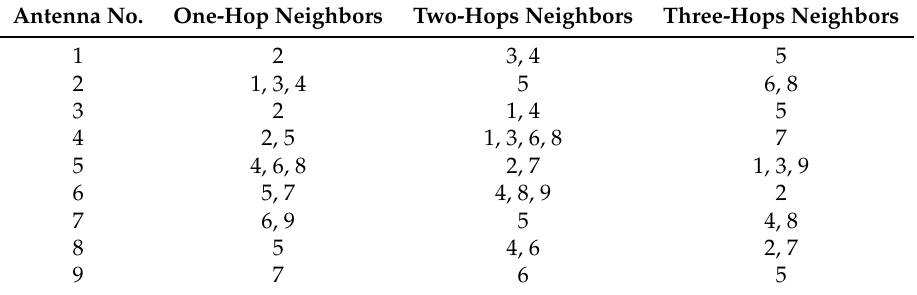
Table 3. The neighbor map of 9 antennas after the third round broadcasting. Antenna